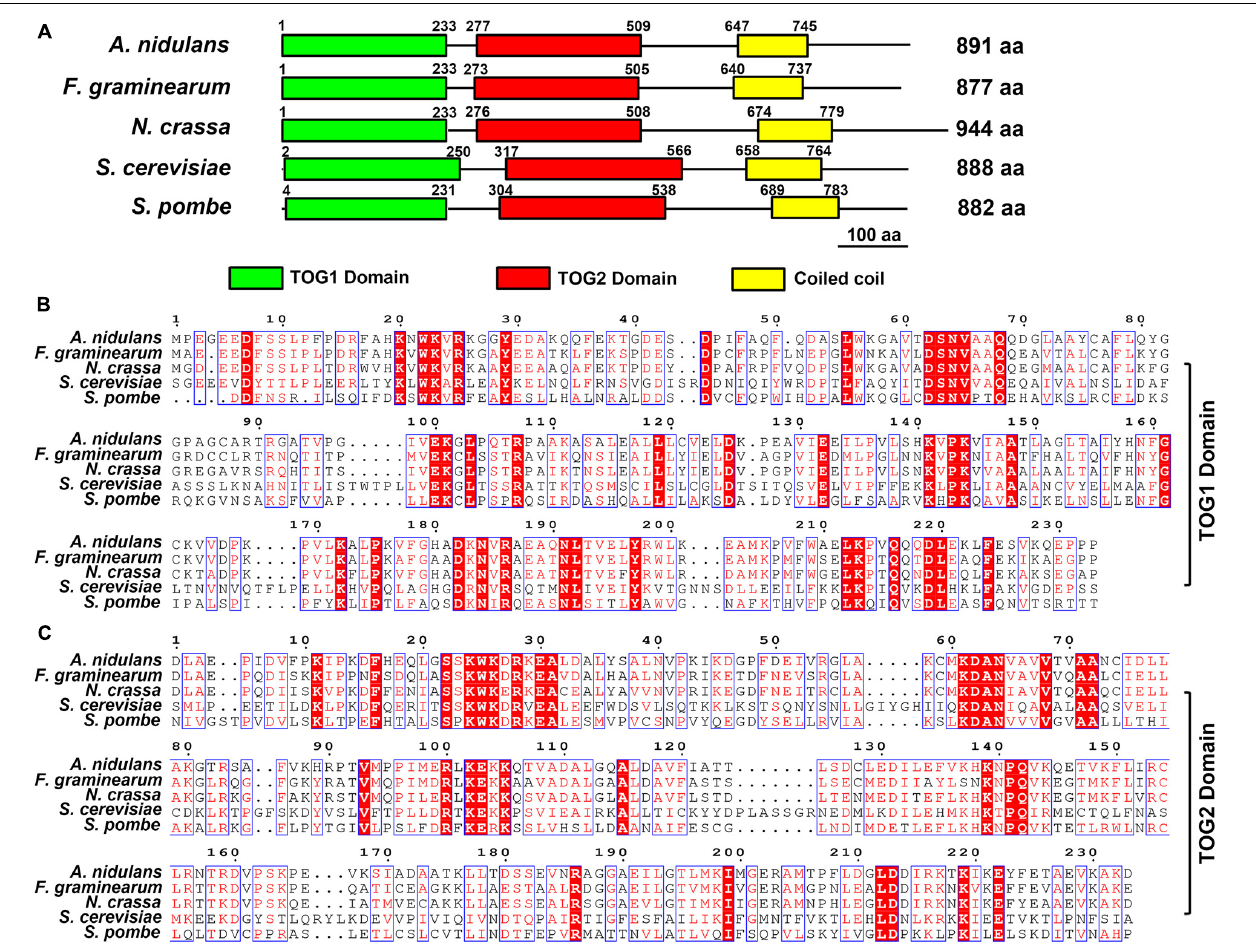
FIGURE 1 | Domain analysis of Stu2 homologs and sequences alignment. (A) Domain analysis of Dis1/Stu2/XMAP215 homologs in Aaspergillus nidulans (Protein ID: XP_663125.1), Fusarium graminearum (Protein ID: XP_011319522.1), Neurospora crassa (Protein ID: XP_956946.3), Saccharomyces cerevisiae (Protein